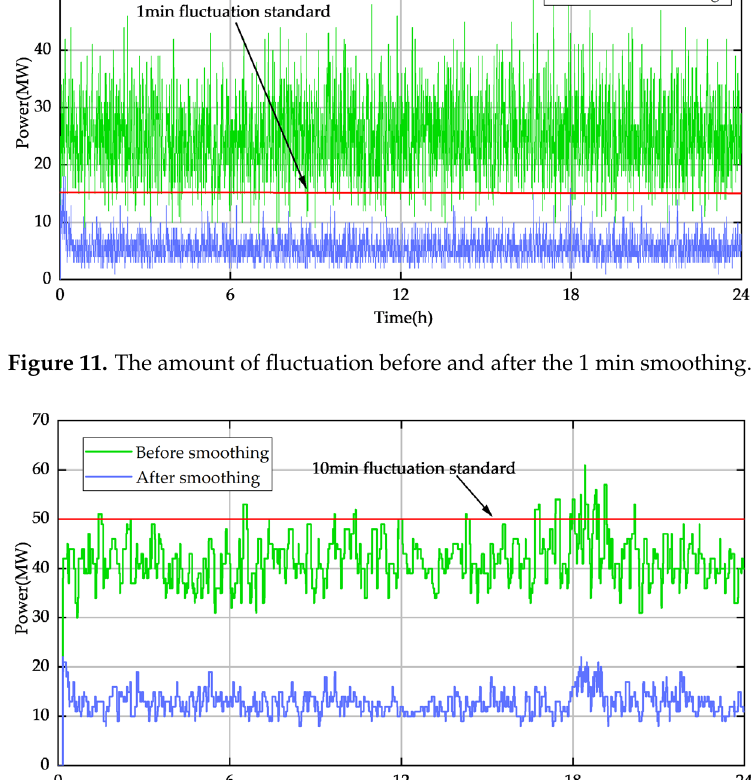
Figure 12. The amount of fluctuation before and after the 10 min smoothing.